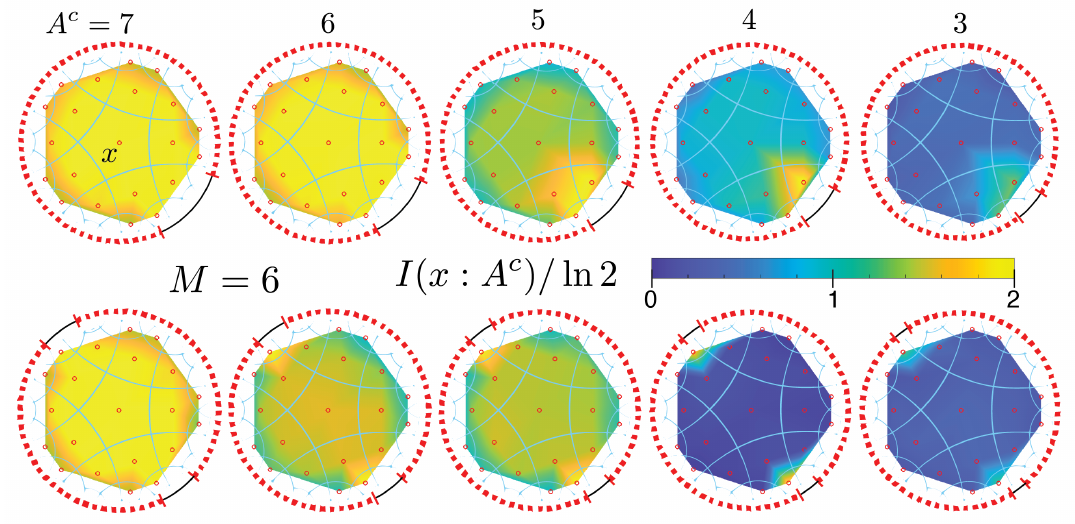
Figure 20 . Teleportation fails according to Lemma 3.1 when there is not enough entanglement shared between A and A c to teleport all of the bulk qubits. With b = 21 bulk qubits and stack depth M = 6 , we naively expect this crossover to occur around A c ∼ 3 . 5 . This expectation is confirmed by our numerical results. Top row: single contiguous measured region A . Bottom row: pair of diametrically opposed regions A = A , each averaged over 100 random product-state 1 ∪ A 2 measurement